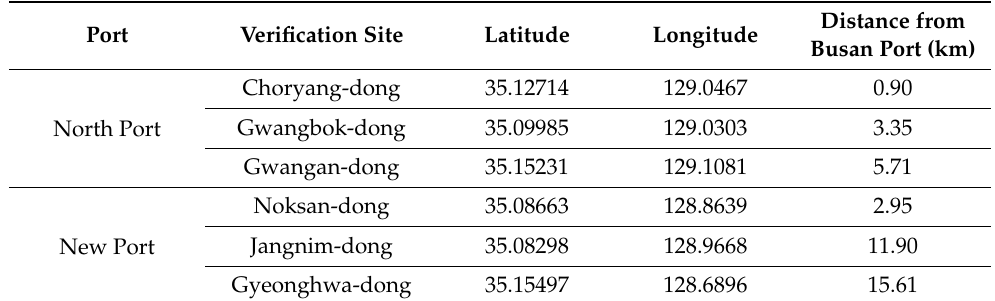
Table 9. Verification point information and distance information between port and measurement point.